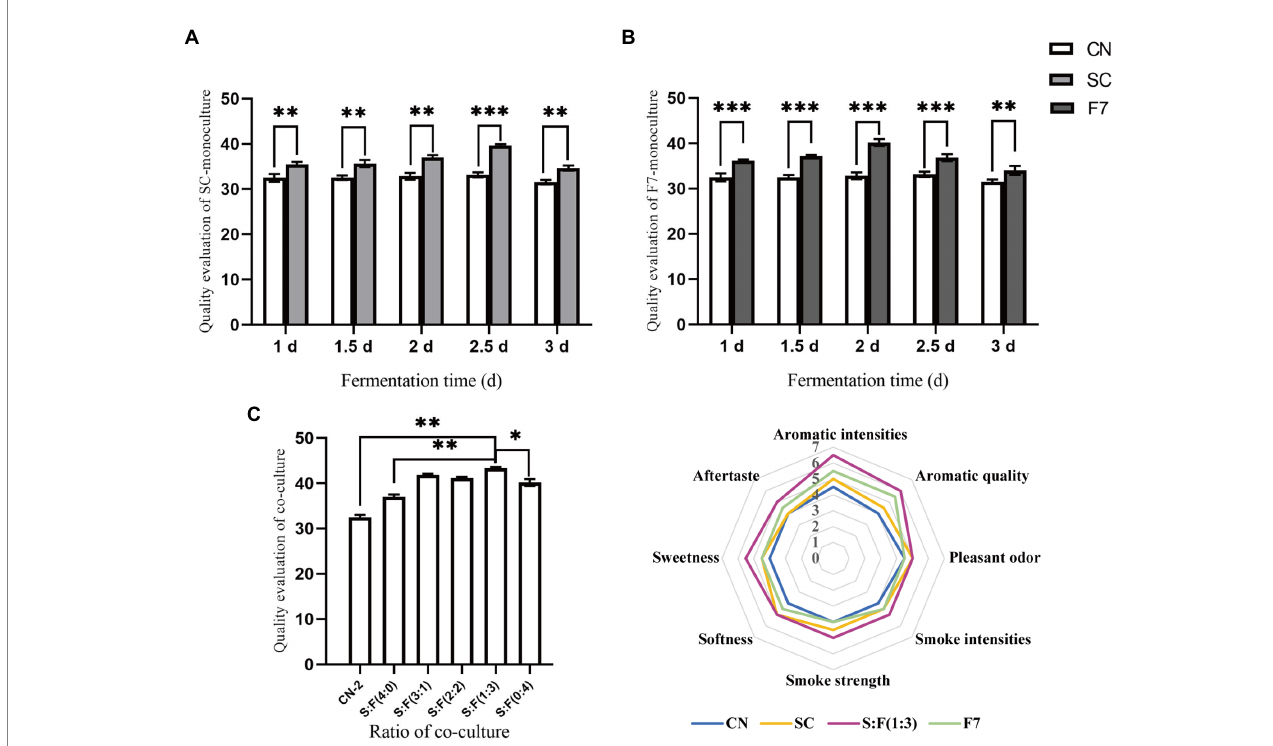
FIGURE 2 Dynamic analysis of FCT quality response to Bacillus kochii SC mono-culture (A) , Filobasidium magnum F7 mono-culture (B) , co-cultivation at different mixing ratios (C) , and sub-quality indicators evaluation of co-cultivation (D) . CN represents the control group. SC represents B. kochii SC mono-culture samples. F7 represents F. magnum F7 mono-culture samples. S:F represents the sample of B. kochii SC- F. magnum F7 co-culture. Error bars represent the standard deviation of the samples (triplicate). p value represents by an asterisk “*” (*: 0.01 < p ≤ 0.05; **: 0.001 < p ≤ 0.01, ***: p ≤ 0.001; ns: no significant